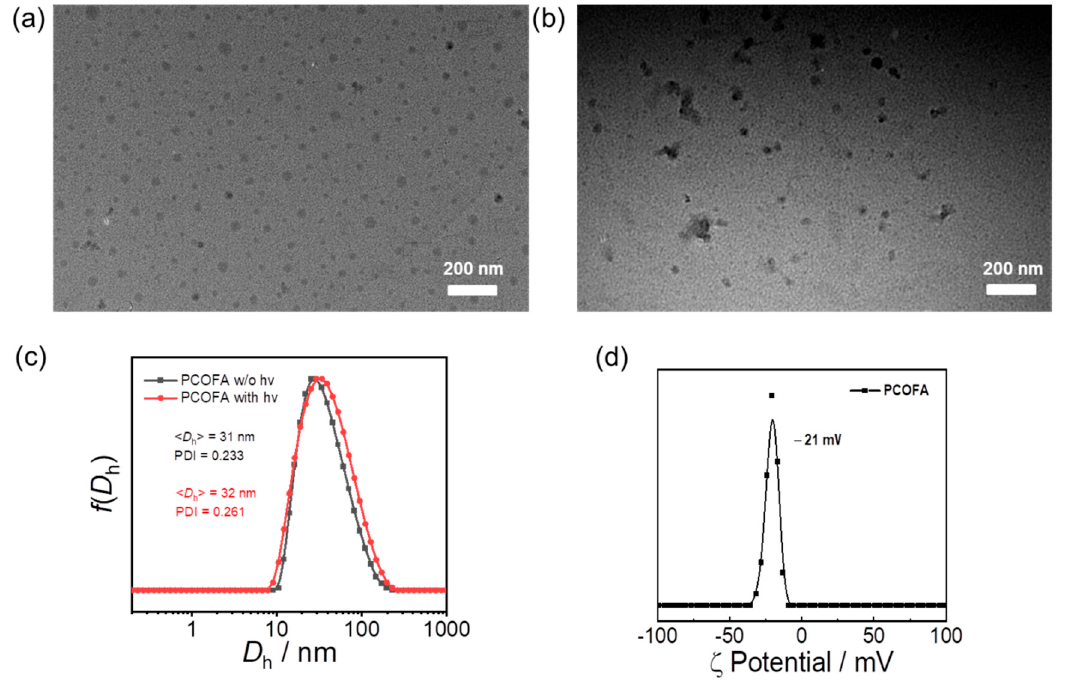
Figure 2. ( a , b ) TEM images of aqueous dispersions (0.1 g/L) of PCOFA micelles ( a ) without and ( b ) with irradiation for 2 h; ( c ) intensity-average hydrodynamic distributions of PCOFA micelles without and with light irradiation; ( d ) zeta potential of PCOFA